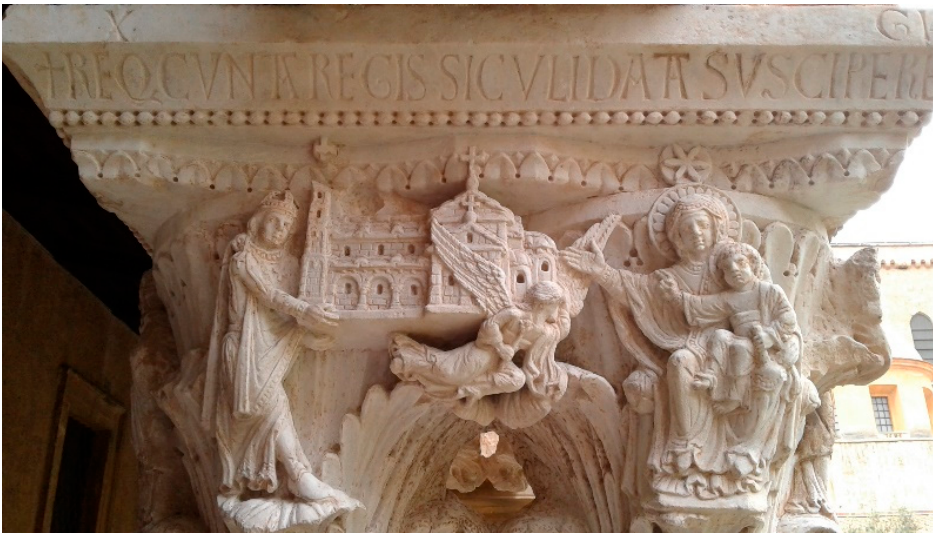
Figure 5. William II of Hauteville offering the Cathedral of Monreale to the Virgin , carved capital, 1177–1183. Monreale, Cathedral, Cloister. Photo took by author.